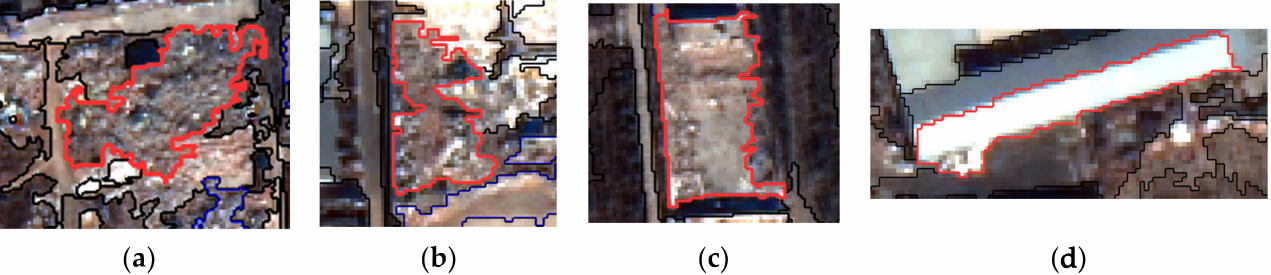
Figure 5. Geometric shapes of construction waste: ( a ) Irregular shape, ( b ) irregular shape, ( c ) standard rectangular, ( d ) regular shape of building.